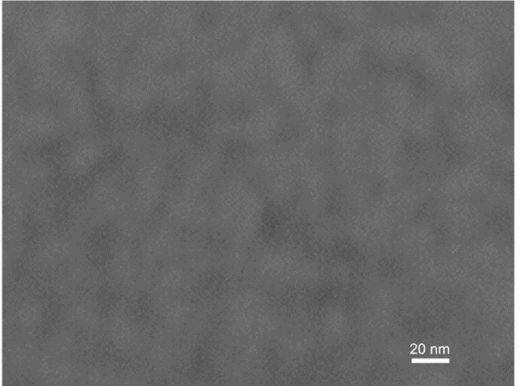
Figure 9. TEM image of the La − Si − O − N glass indicating some features of either phase-separation or compositional difference in the range of ~10 to 30 nm [9].